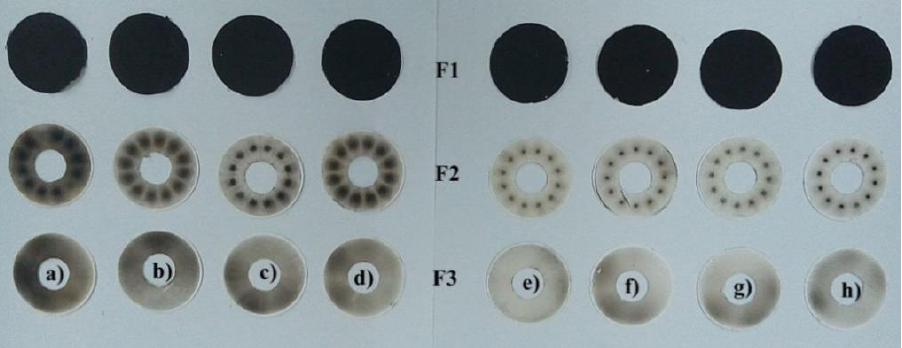
Figure 8. Sets of collection filters F1 PM > 10, F2 PM 10 – 2,5, and F3 < 2,5 for individual measurements of variant 2: ( a ) M1, ( b ) M2, ( c ) M3, ( d ) M4, ( e ) M5, ( f ) M6, ( g ) M7, and ( h ) M8.